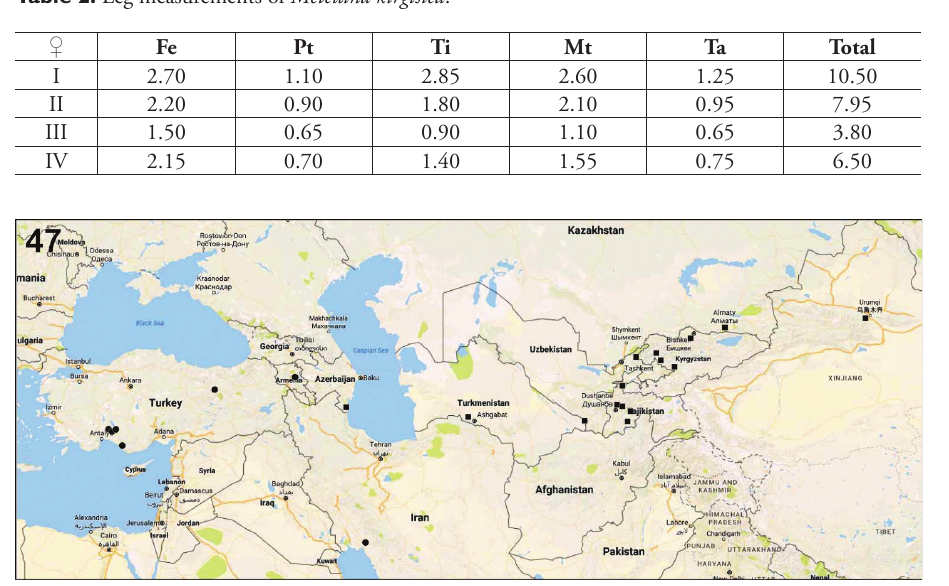
Figure 47. Distribution records of Metellina orientalis (circle) and M. kirgisica (square). Abdomen with three pairs of humps, anterior the largest, two posterior humps less distinct. Abdomen with distinct pattern as shown on Figs 11–13, 16; venter with wide light